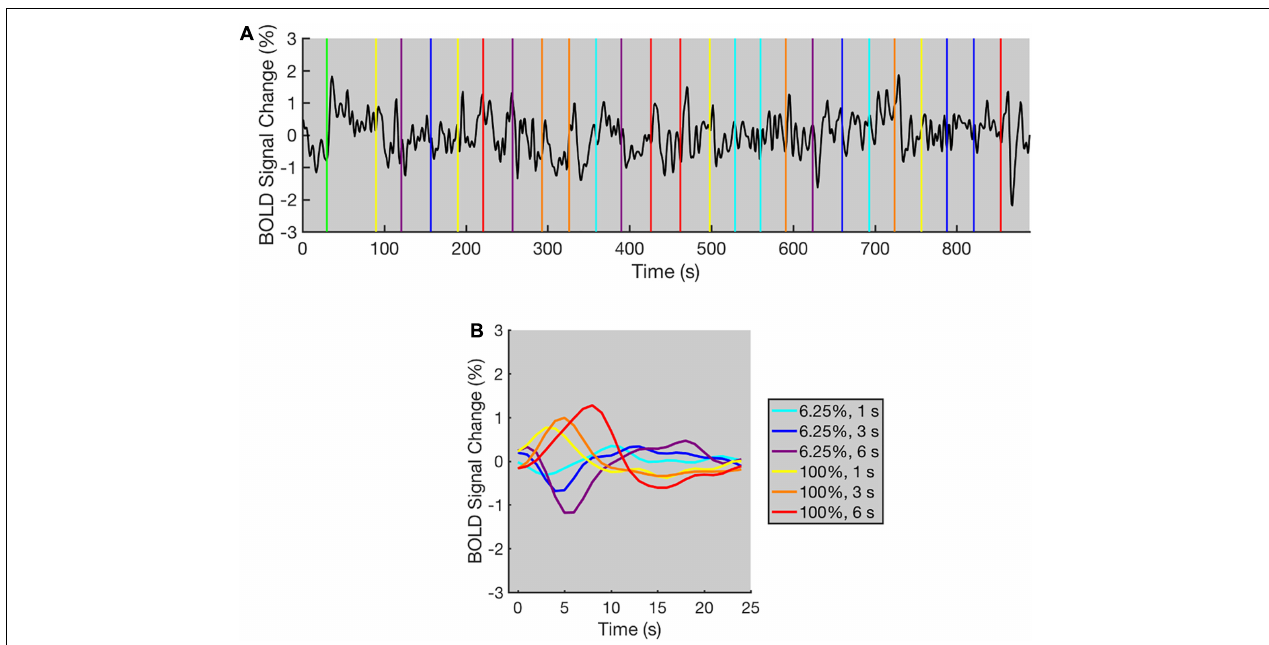
FIGURE 2 | The typical BOLD time course for the contrast adaptation experiment (data from one representative selected voxel). (A) The BOLD time course for a single run. The green vertical line indicates the appearance of adaptation stimulus. All other colored vertical lines indicate the beginning of each trial, and the colors of vertical lines indicate the contrast level and duration of test stimuli. The time course displays positive and negative deflections following the contrast level increments and decrements in most trials. A low-pass filter (low-pass frequency = 0.2 Hz) was applied to the original time course for a clearer demonstration. (B) The averaged BOLD responses under each condition for all trials within three runs. The BOLD responses increased or decreased immediately after the contrast level increments or decrements, respectively. The colors of BOLD responses indicate the contrast level and duration of test